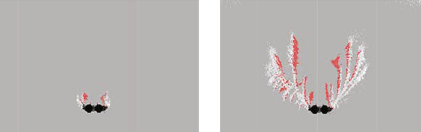
Figure 20: Acoustic emission damage cloud of 350-mm double